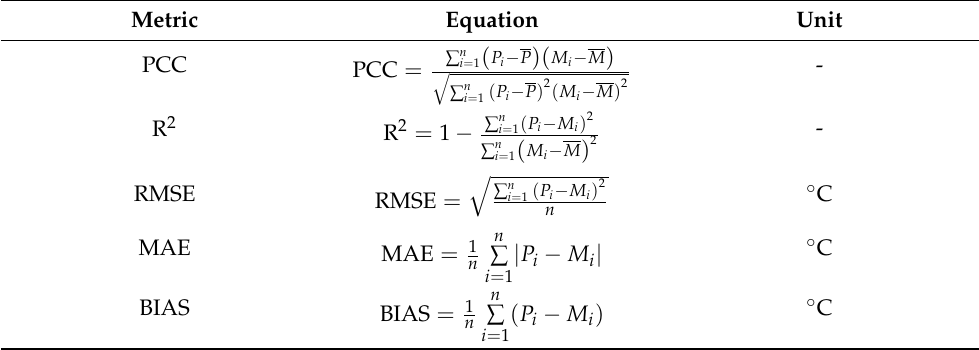
Table 2. The equations and detailed information of PCC, R 2 , RMSE, BIAS, and MAE. P i and M i represent the ith fusion value and ground measurement, respectively. P and M indicate the average values of fusion temperature and in situ measurements. n is the number of the